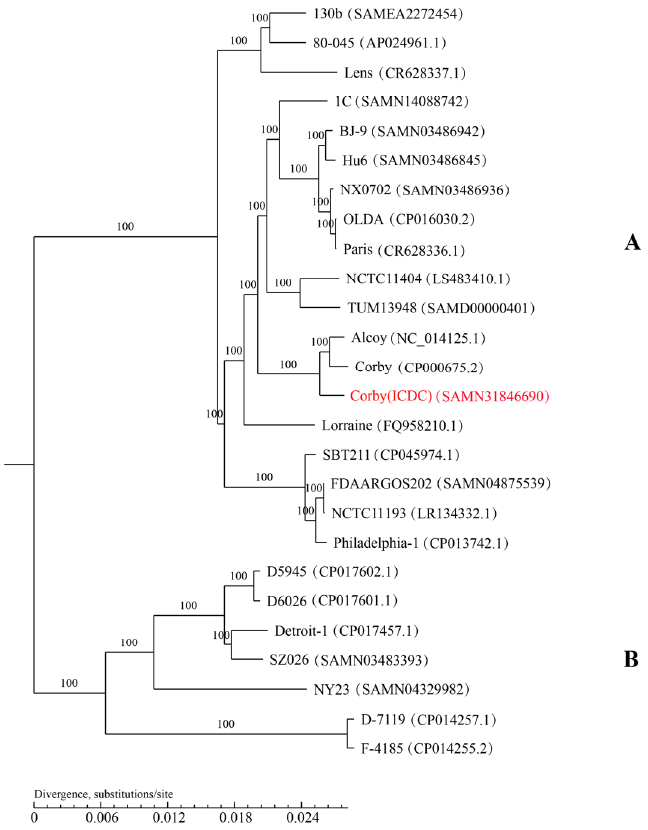
Figure 4. The phylogenetic tree is based on the core genes of Legionella pneumophila . The whole genome of L. pneumophila strain Corby (ICDC) (red label) isolated from a patient was compared to the genomes of serotype 1 L. pneumophila .